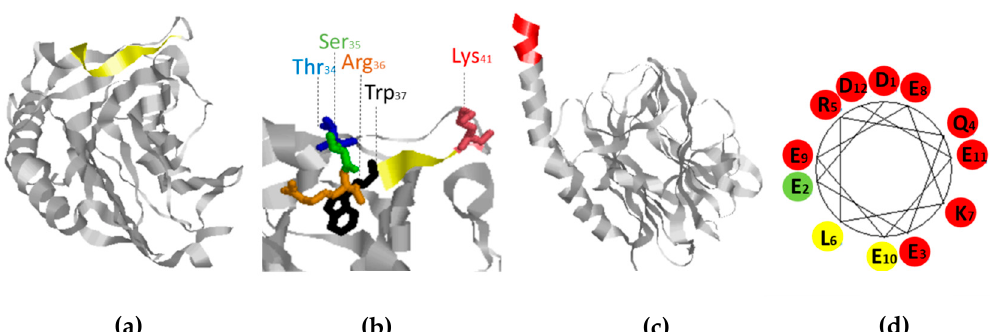
Figure 5. Visualization of the identified epitopes in the native structure of calreticulin. ( a ) Visualization of the mAb FMC 75 epitope. ( b ) Visualization of the essential amino acids in the mAb FMC 75 epitope (amino acids 34–). ( c ) Visualization of the N-terminal region (363–367) of the mAb 16 epitope (362–373). ( d ) α -helical wheel representation of mAb 16. “Red” represents aas which are critical for antibody binding. ”Yellow” represents aas semi-critical aas. “Green” represents non-critical aas residues.